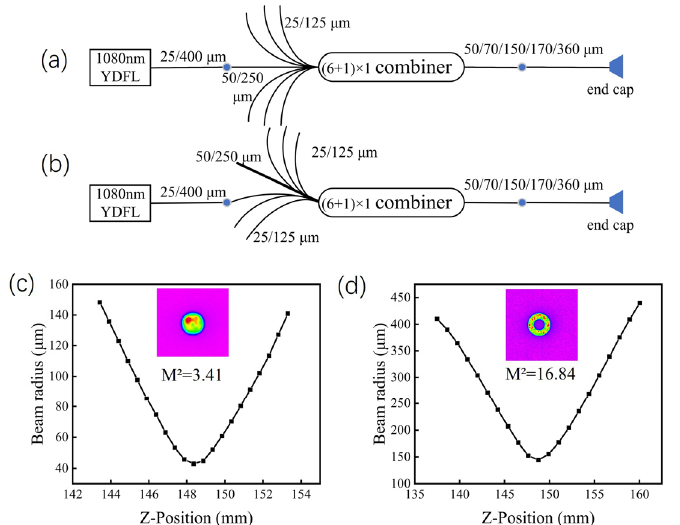
Figure 6. The diagram of testing performance and the output beam quality of (6 + 1) × 1 fiber signal combiner ( a ) The diagram of testing central port; ( b ) The diagram of testing side port; ( c ) The beam quality of central port; ( d ) The beam quality of side port.